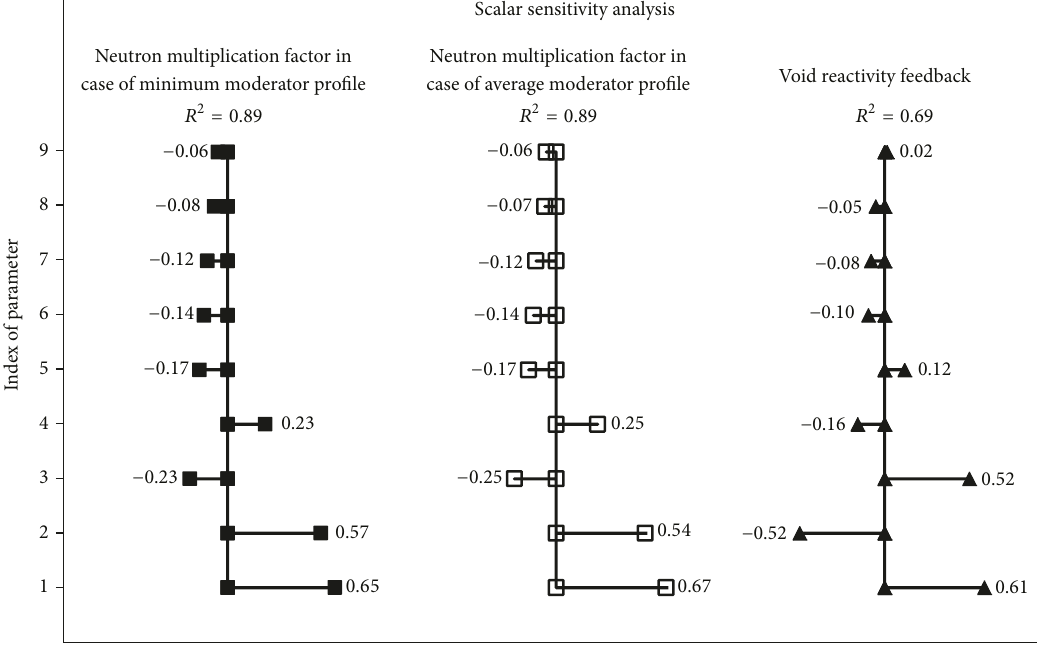
Figure 9: Results of scalar sensitivity